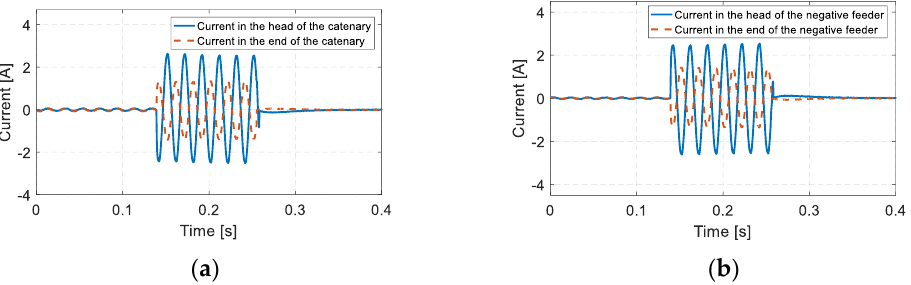
Figure 21. Current in the catenary and the negative feeder at the AT subsection 2: ( a ) Current in two terminals of the catenary and ( b ) current in two terminals of the negative feeder.